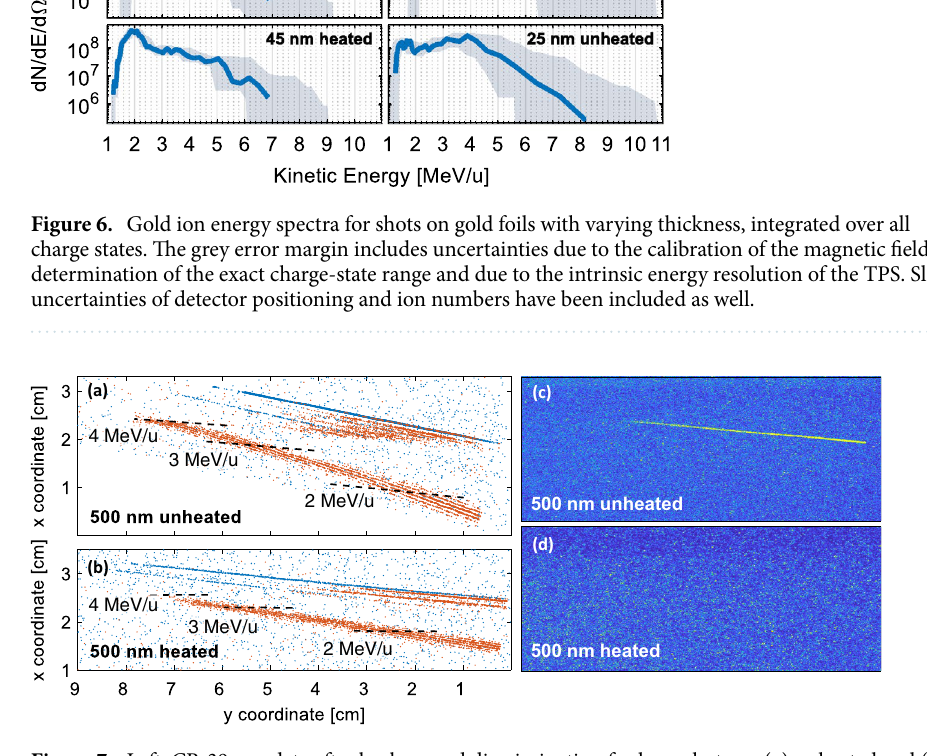
Figure 7. Left: CR-39 raw data after background discrimination for laser shots on ( a ) unheated and ( b ) heated 500 nm thick gold foils. Right: IP raw data for laser shots on ( c ) unheated and ( d ) heated 500 nm gold